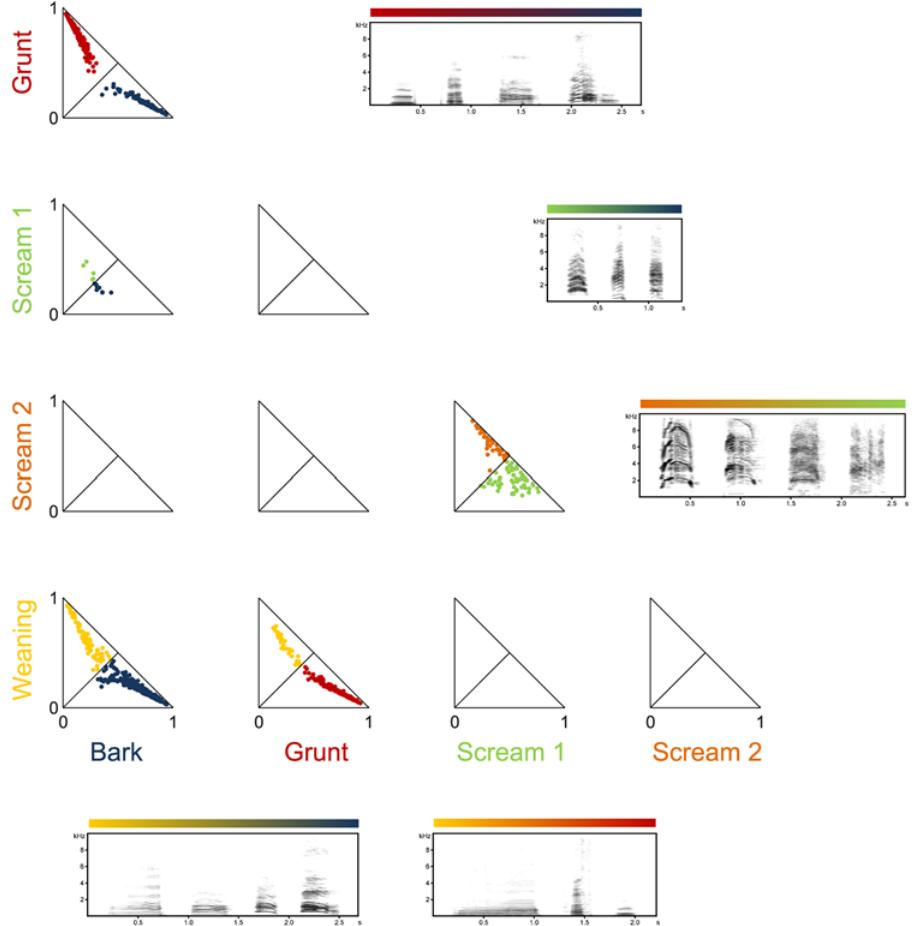
Fig 6. Pairwise comparisons of cluster segregations. Two-dimensional projections of memberships of calls belonging to the grunt (red), scream 1 (green), scream 2 (pink), weaning (yellow), and bark (blue) cluster. Every call is represented once (by closest and second closest cluster). Diagonal lines in the panels represent identical memberships. Spectrograms represent transitions from most typical call of cluster A to most typical call of cluster B with hybrids close to the joint cluster borders. Sound examples can be found in the supporting